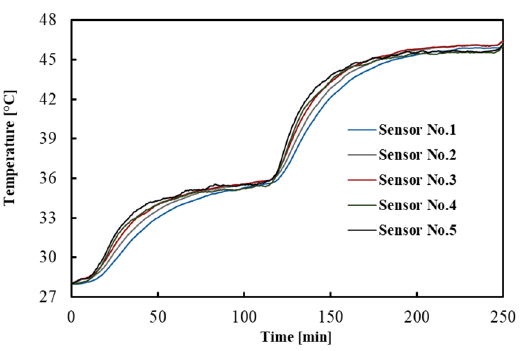
Figure 2. Temperature distribution across the tissue depths. This measurement refers to one of the experiments performed in the brain.